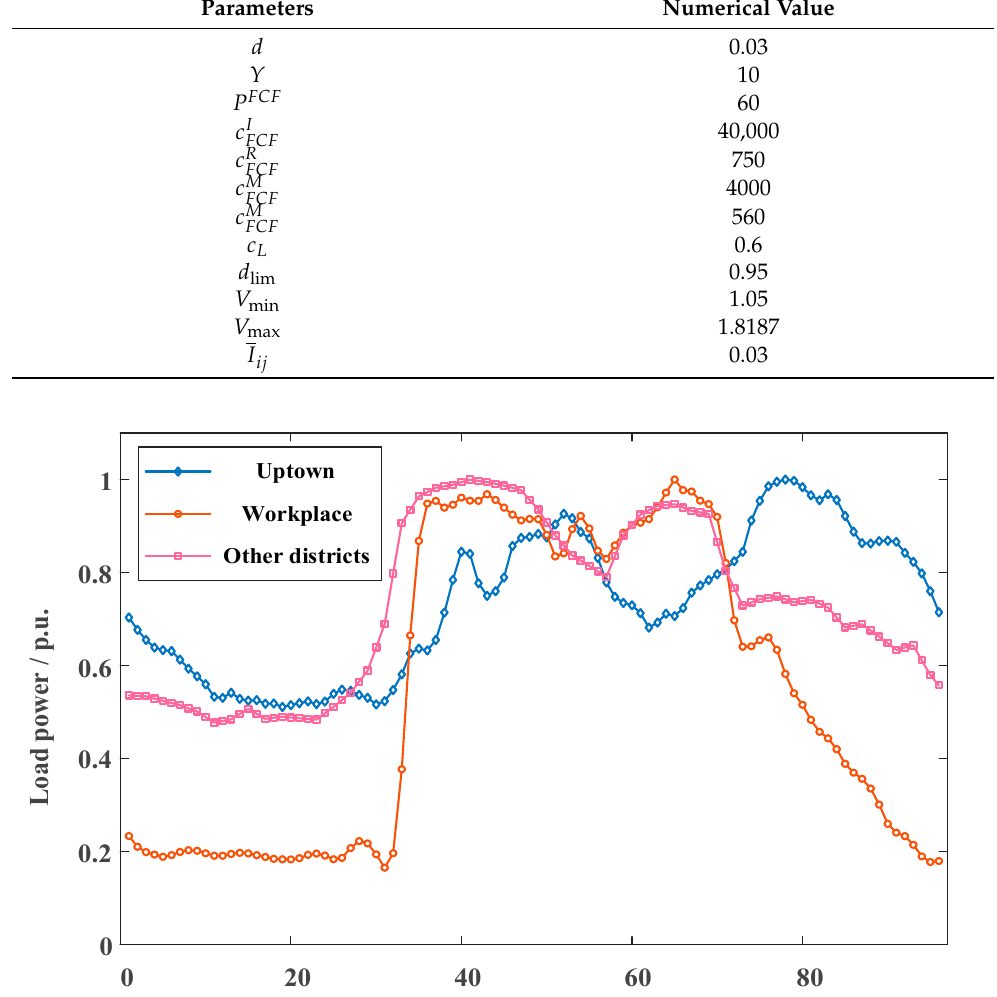
Table 2. Example parameter values.